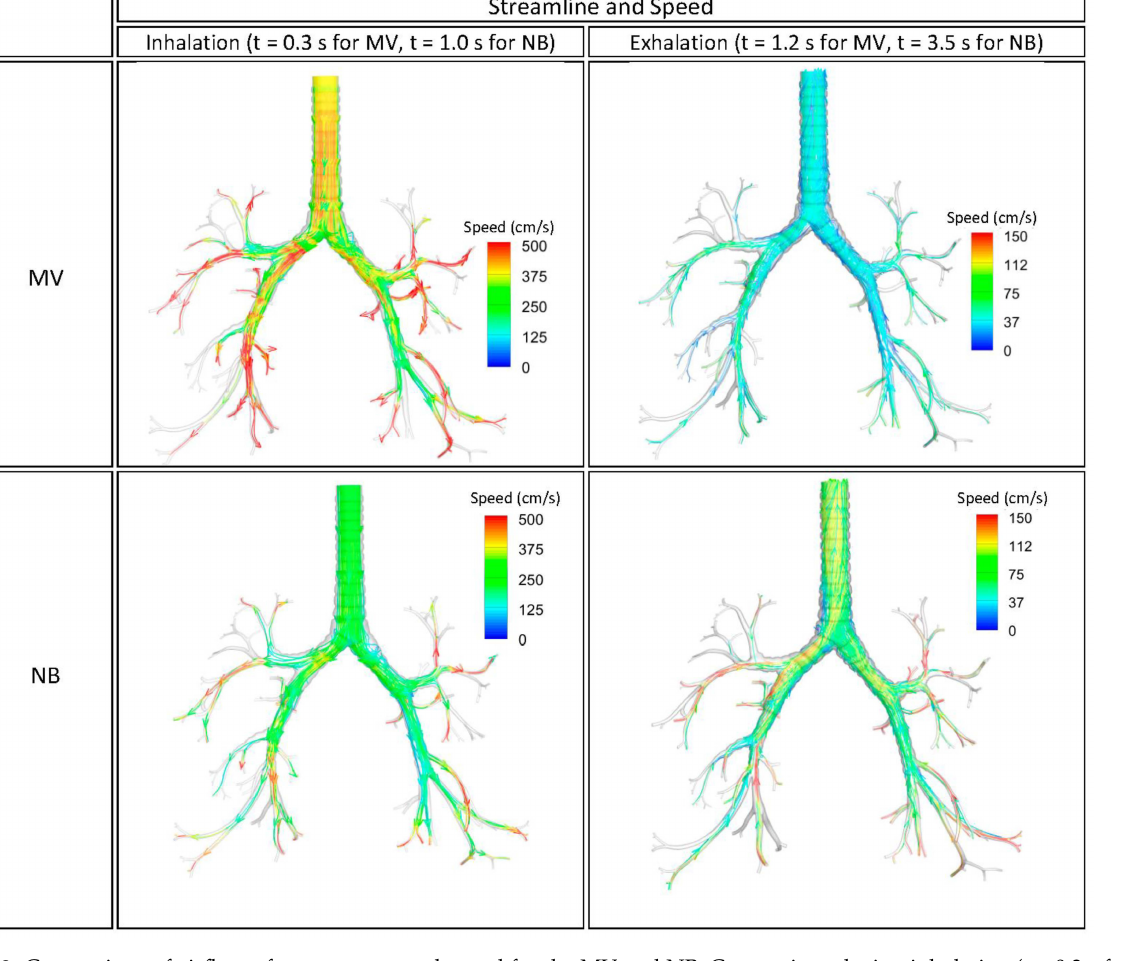
Figure 3. Comparison of airflow of stream trace and speed for the MV and NB. Comparison during inhalation (t = 0.3 s for MV, t = 1.0 s for NB) and exhalation (t = 1.2 s for MV, t = 3.5 s for